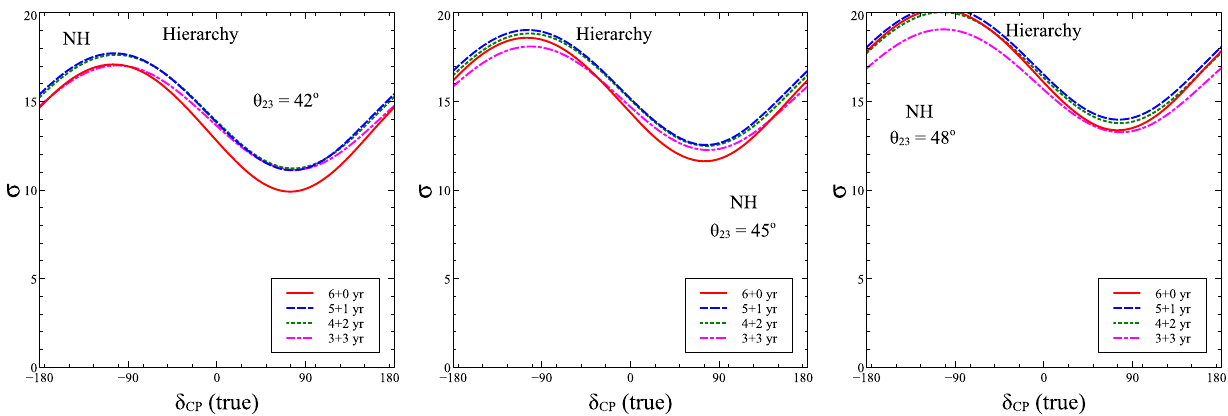
Fig. 3 Hierarchy sensitivity vs δ CP (true) in NH for different combinations of neutrino and antineutrino ratio. The left/middle/right panel is for θ = 42 ◦ / 45 ◦ / 48 ◦ 23 (true)